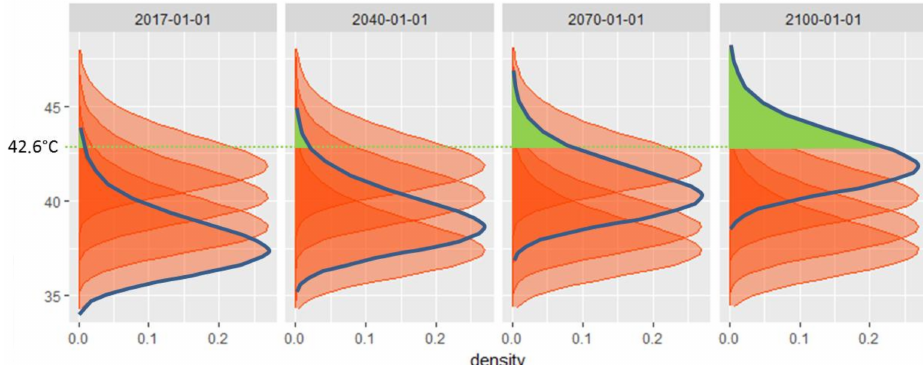
Figure 6. Density